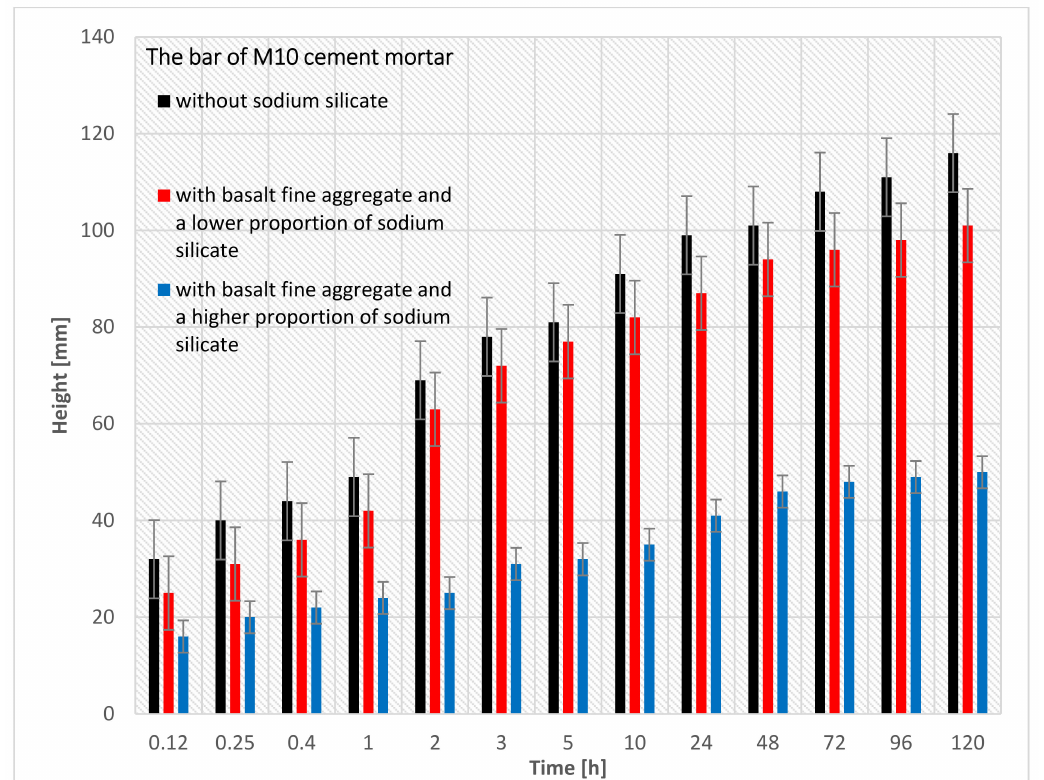
Figure 9. The results of the capillary suction of the M10 cement mortar bar with basalt fine aggregate: without sodium silicate, with a lower proportion of sodium silicate, and with a higher proportion of sodium silicate.